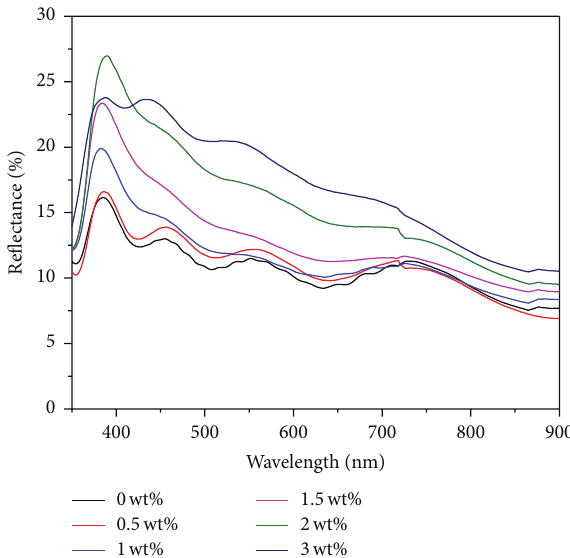
Figure 3: Reflectance spectra of TiO 2 thin films with varying wt% of carbon black.